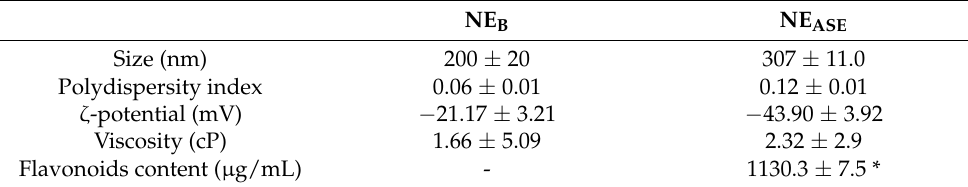
Table 1. Physicochemical characterization of